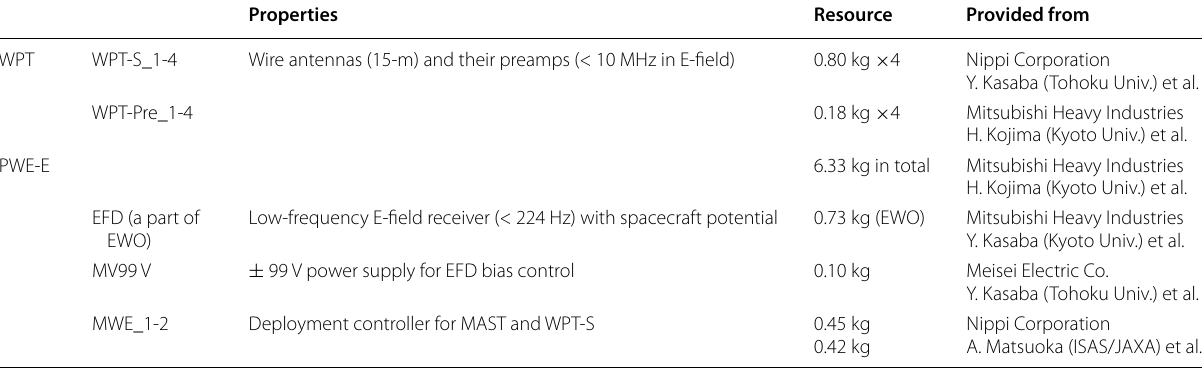
Table 1 Specification and the provisional teams of the WPT-S and EFD